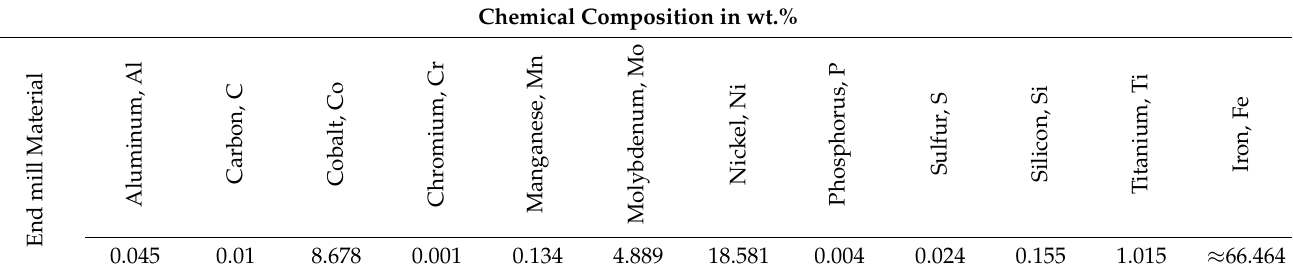
Table 2. Chemical composition of the end mill. Chemical Composition in wt.%